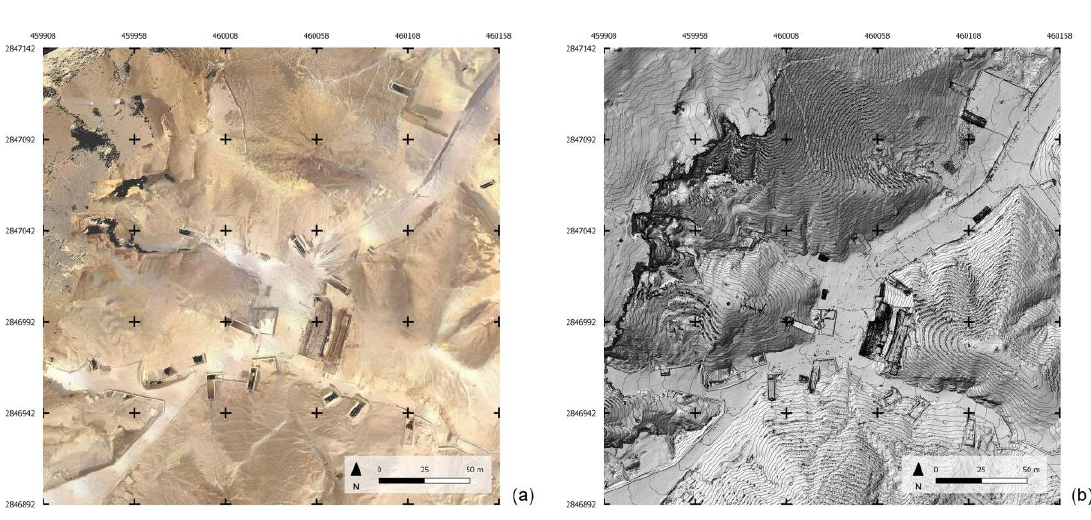
Figure 12. Zooming in from the Figure11, upgraded mapping of modern artifacts concerning the entrance of KV11 ( a ) and KV55 ( b ) in comparison with the Theban Mapping Project. Finally, an application based on the models so far obtained by the 2018 3D survey campaign was prepared to offer a virtual visit through 3D HOP (3D Heritage Online Presenter), an open-source software package for the creation of interactive web presentations of high-resolution 3D models, oriented to the Cultural Heritage field [51] (Figure 13). 3DHOP allowed the creation of an integrated interactive visualization of the photogrammetric, LiDAR and SLAM based 3D models so far generated, embedding all of them directly inside a standard web page based on HTML and JavaScript